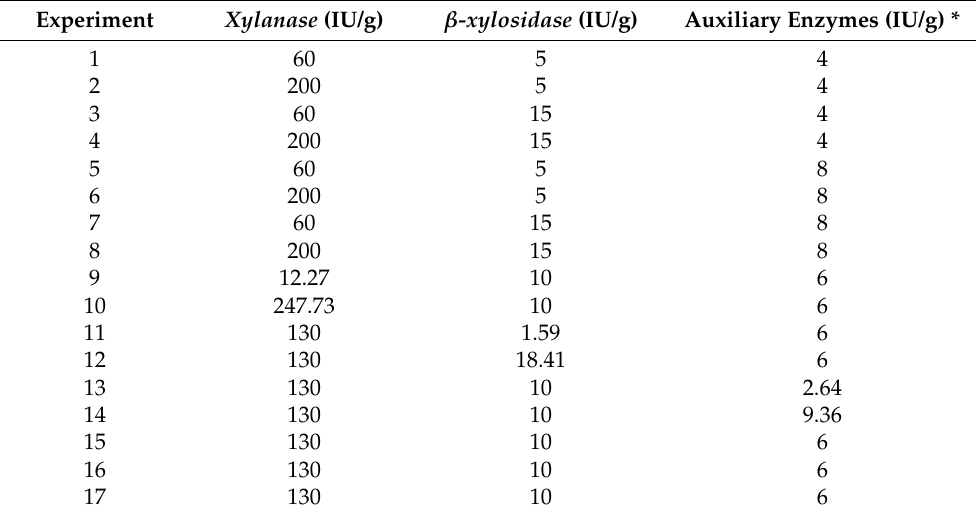
Table 4. Central composite design (with rotatable/star points) experiments for determination of complete hydrolysis of xylan.